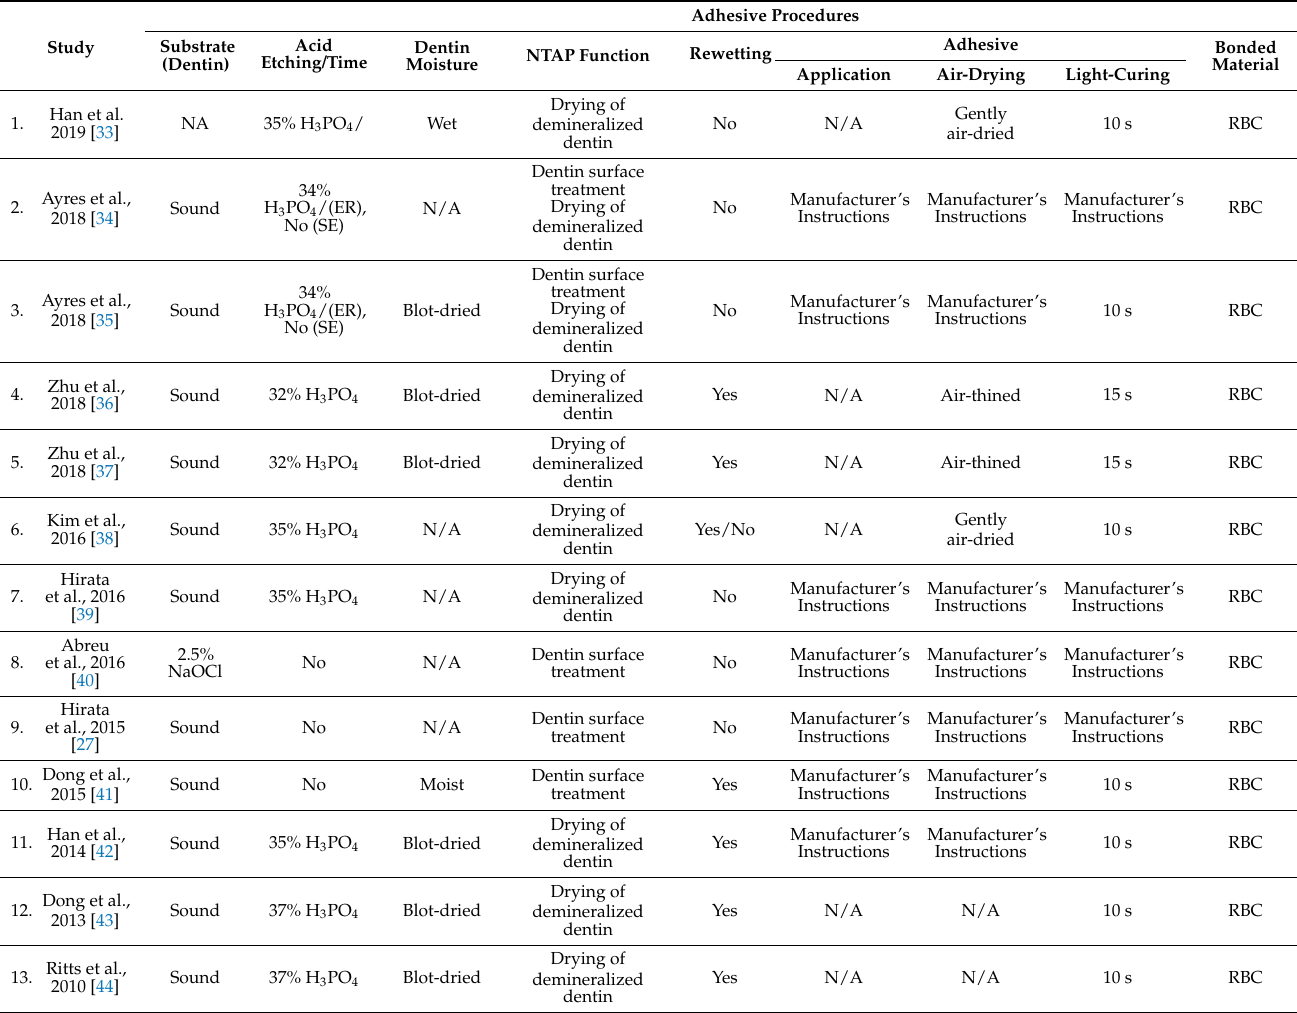
Table 2. Adhesive procedures applied in studies included in the